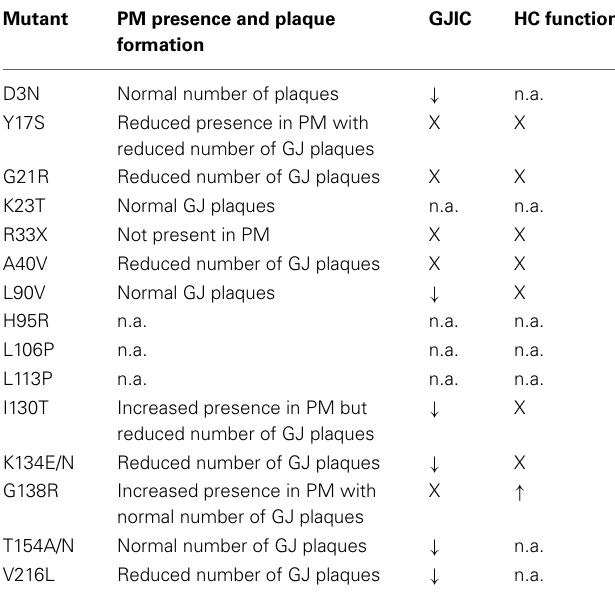
Table 3 | List of ODDD mutations linked to upper motor neuron dysfunction, tremor, gait disturbances, and spasticity, indicating